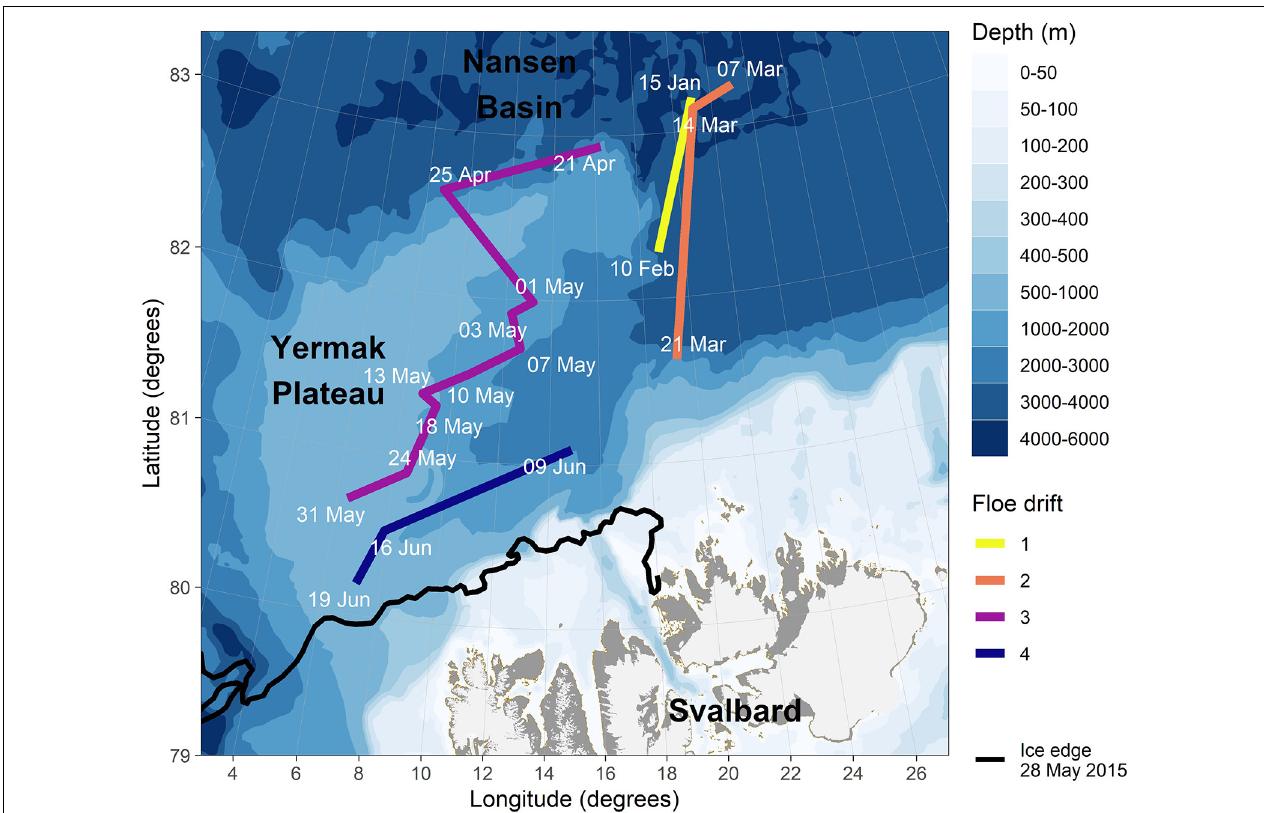
FIGURE 1 | Zooplankton sampling stations during the four ice drifts during N-ICE2015. Floe 1 drift (10 February), Floe 2 drift (7, 14, and 21 March), Floe 3 drift (25 April, 3, 10, 18, 24, and 31 May) and Floe 4 drift (9, 16, and 19 June). The black line indicates the 10%+ ice edge on 28